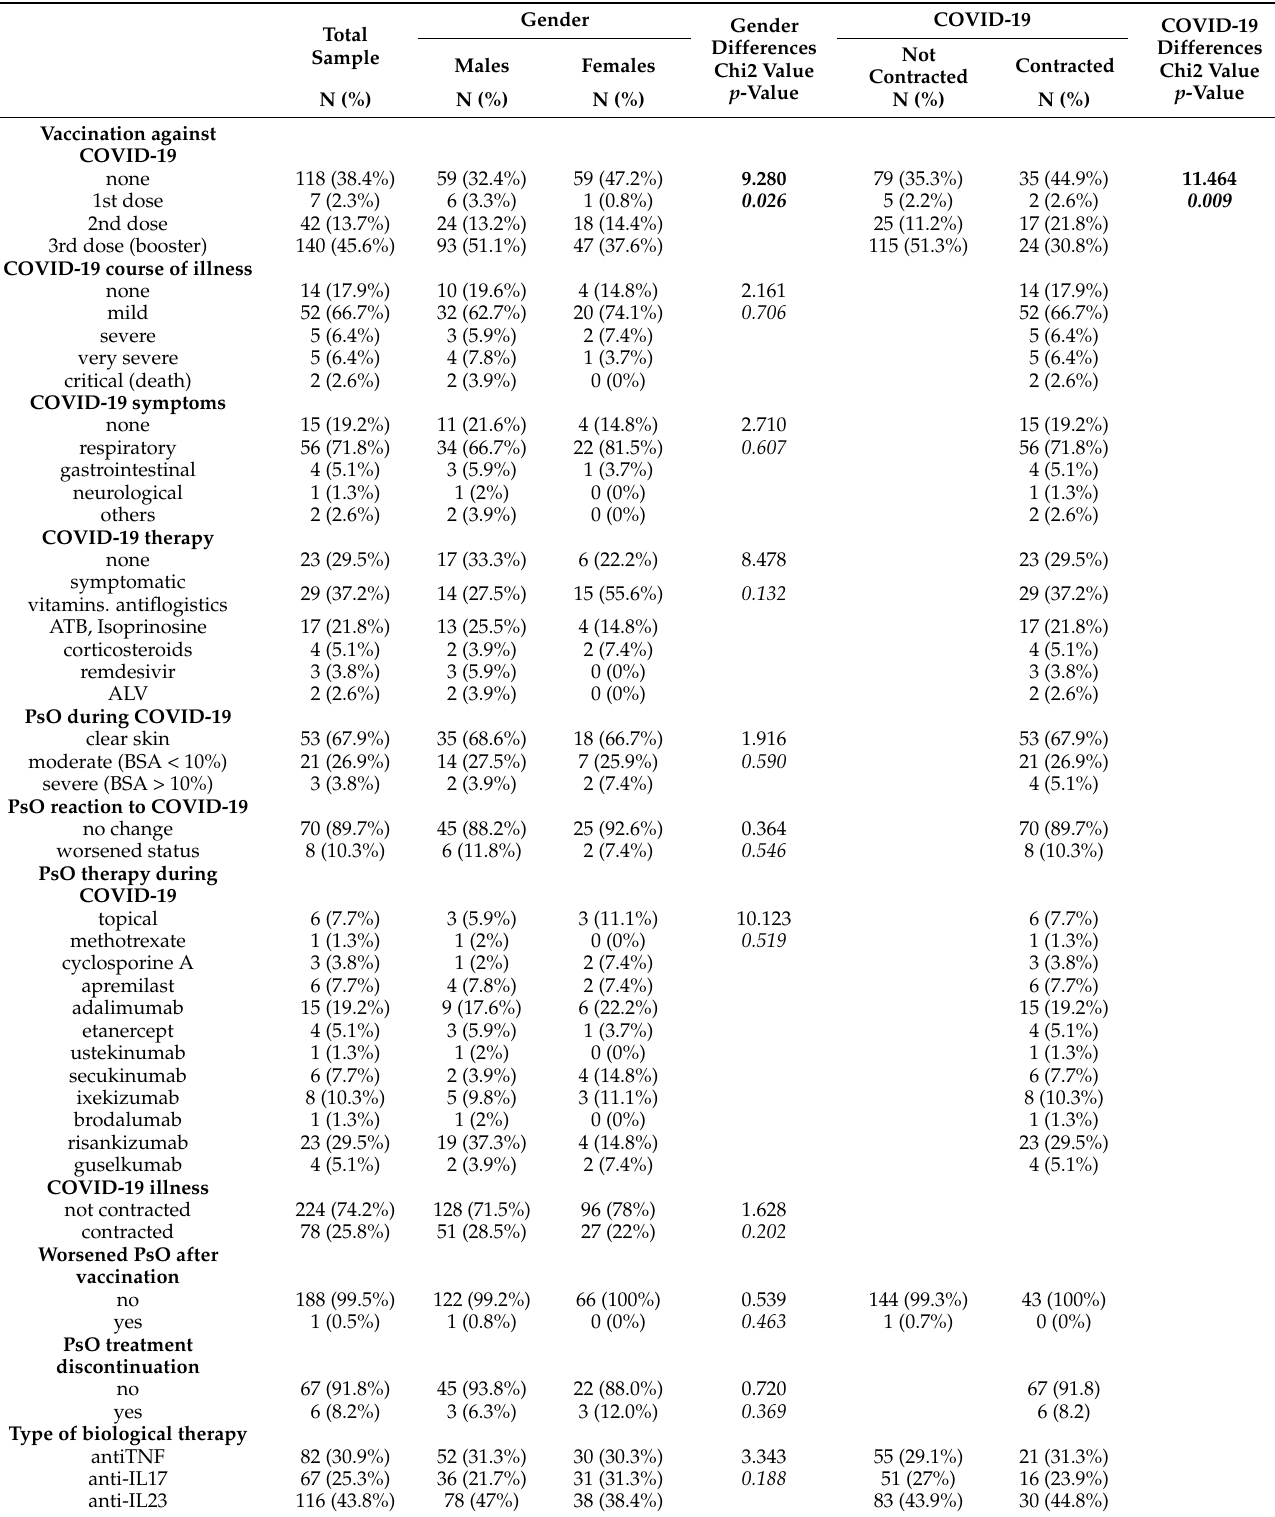
Table 3. Vaccination status, COVID-19 symptoms and treatment, impact on psoriasis and treatment variables (numbers and relative prevalence in %) presented for the total sample and stratified accord- ing to gender and COVID-19 contraction status, differences tested with Pearson’s chi-squared